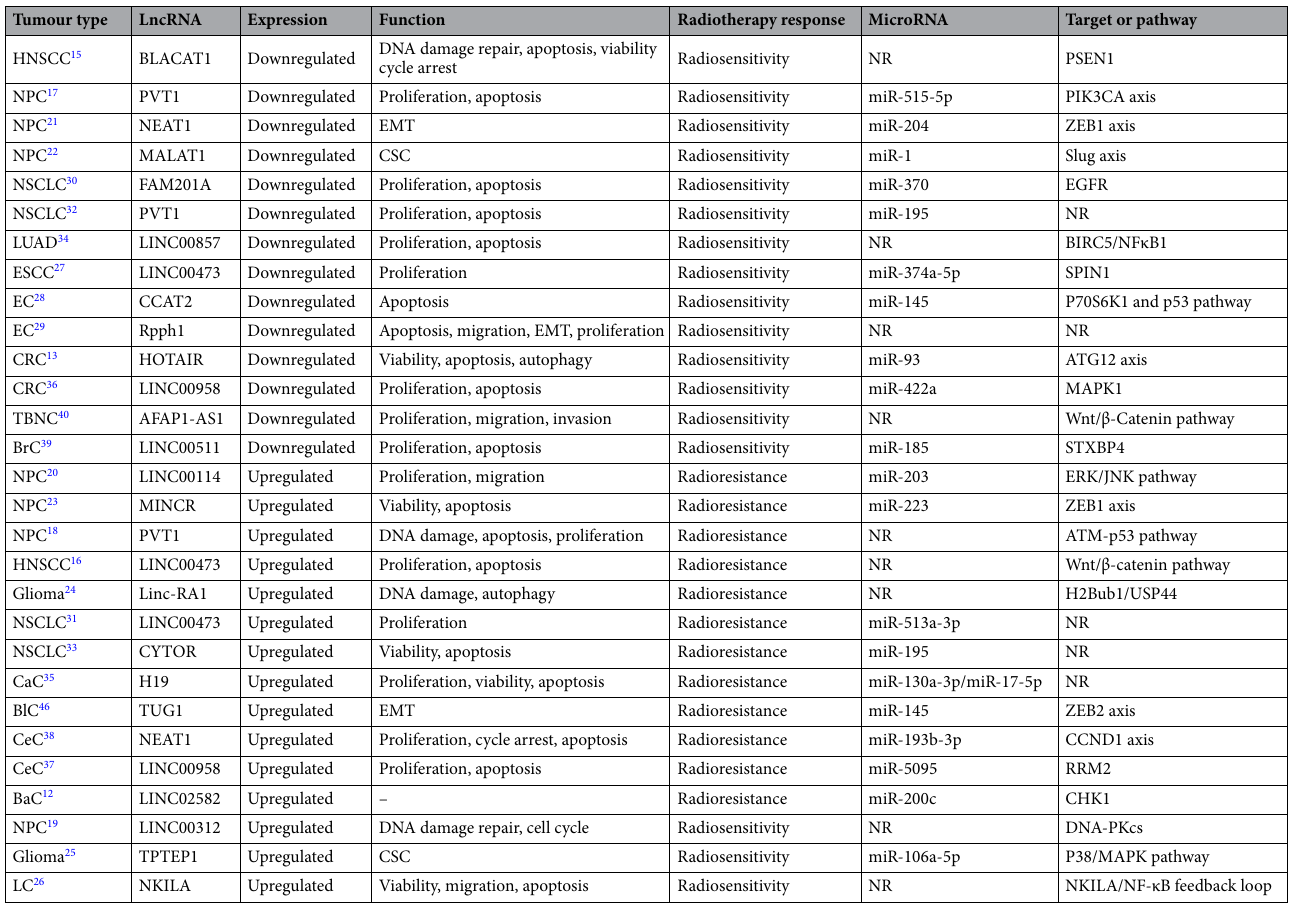
Table 2. LncRNA-microRNA pathways related to radiosensitivity and radioresistance. NR not reported, HNSCC head and neck squamous cell carcinoma, NPC nasopharyngeal carcinoma, ESCC